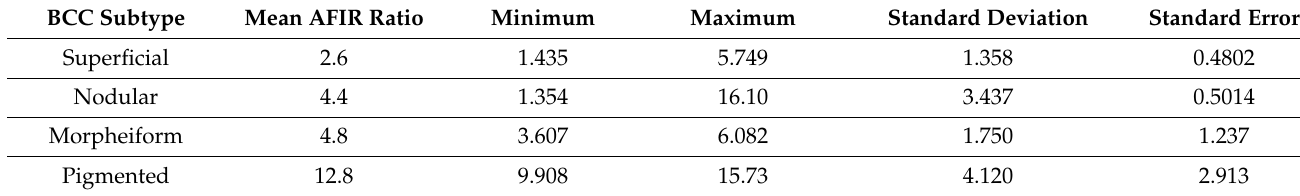
Table 1. Mean AFIR among different BCC subtypes.